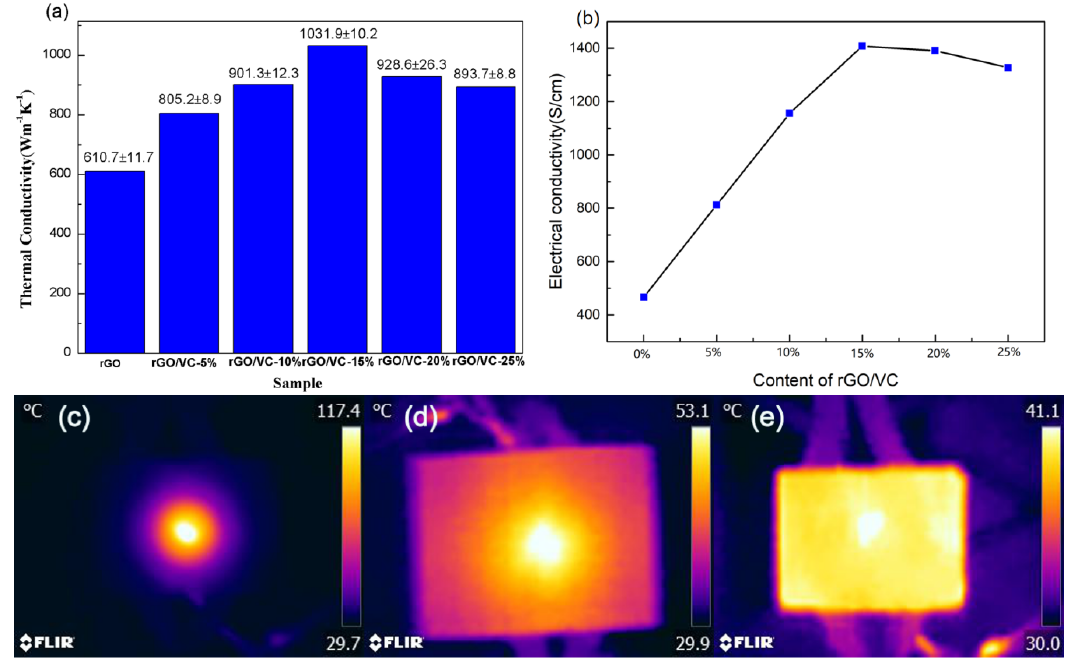
Figure 4. ( a ) In-plane thermal conductivity of rGO/VC- x % films; ( b ) electrical conductivities of rGO films with different contents of vitamin C; infrared surface thermography of ( c ) GO/VC-15%, ( d ) rGO and ( e ) rGO/VC-15% films.